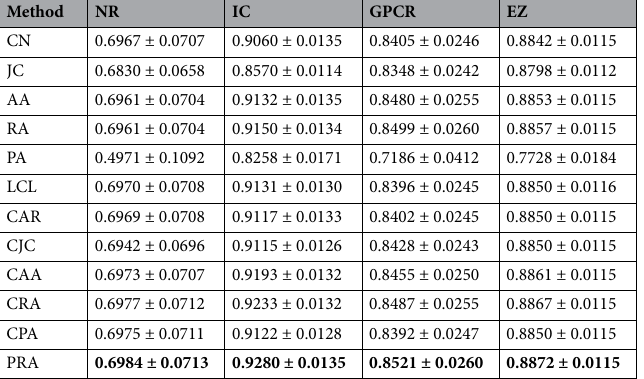
Table 2. AUC values of the proposed and alternate methods for the four DTI datasets. Each experiment was executed 100 times and the average values along with the standard deviations are reported. Bold values indicate best